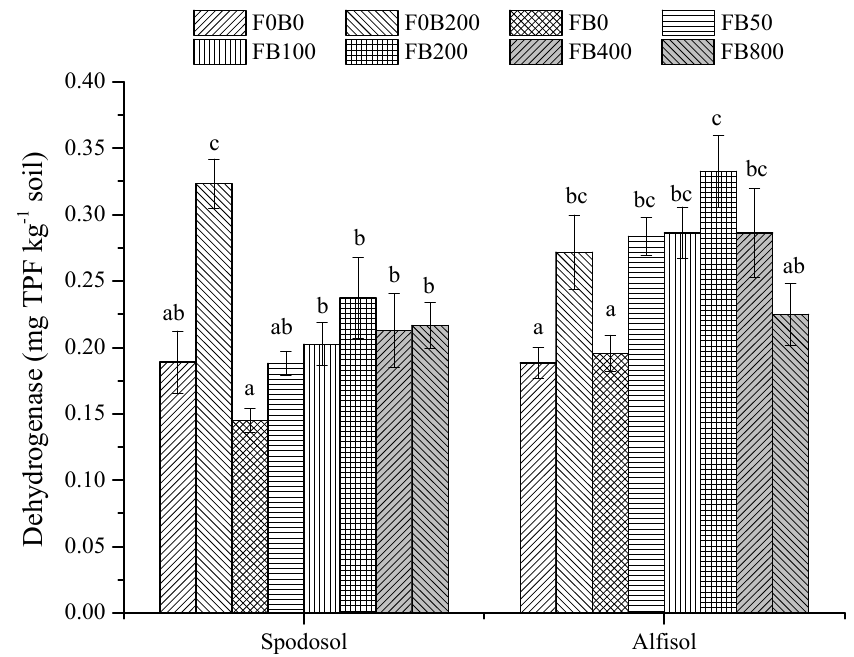
Figure 10. Soil dehydrogenase activity in Spodosol and Alfisol soils affected by different application rates of CNPs. F0B0, control (without fertilizers and CNPs); F0B200, without fertilizers and with CNPs at 200 mg kg − 1 soil; and FB0, FB50, FB100, FB200, FB400 and FB800 represent those with and CNPs at application rates of 0, 50, 100, 200, 400 and 800 mg kg − 1 soil, respectively. Error bars represent the standard error of the mean ( n = 5). The letters a, b and c indicate statistically significant difference at p < 0.05 within each group comparison between the treatments. Bars with no common letters are significantly different ( p < 0.05).